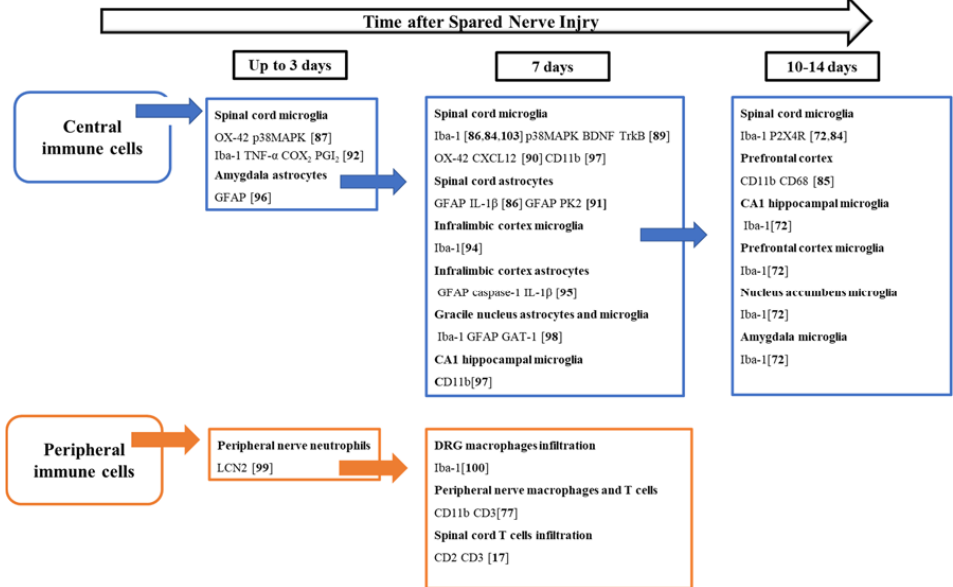
Figure 1. Schematic flow ‐ diagram showing the temporal participation of central and peripheral immune cells after spared nerve injury. The scheme represents key time ‐ points of immune cells activation, which occur throughout the nervous system, particularly at the site of nerve injury, in the dorsal root ganglion (DRG), the spinal cord, and supraspinally, within the brain. Mediators or antigens surface shown are expressed by the cell types indicated. Ionized calcium binding adaptor molecule 1 (Iba ‐ 1); Glial Fibrillary Acidic Protein (GFAP); cluster of differentiation molecule 11B (CD11b); cluster of differentiation 68 (CD68) cluster of differentiation 3 (CD3); cluster of differentiation 2 (CD2); CD11b/c Monoclonal Antibody (OX ‐ 42); P2X purinoceptor 4 (P2X4R); P38 mitogen ‐ activated protein kinases (p38MAPK); Brain ‐ derived neurotrophic factor (BDNF); Tropomyosin receptor kinase B (TrkB); Lipocalin ‐ 2 (LCN2); interleukin 1 β (IL ‐ 1 β ); CXCL12 (C ‐ X ‐ C Motif Chemokine Ligand 12); Prokineticin ‐ 2 (PK2); GABA transporter type 1 (GAT ‐ 1); Tumor necrosis factor alpha (TNF ‐α ); cyclooxygenase ‐ 2 (COX ‐ 2); Prostacyclin (PGI2) [17,72,77,84–87,89–92,94–100,103].